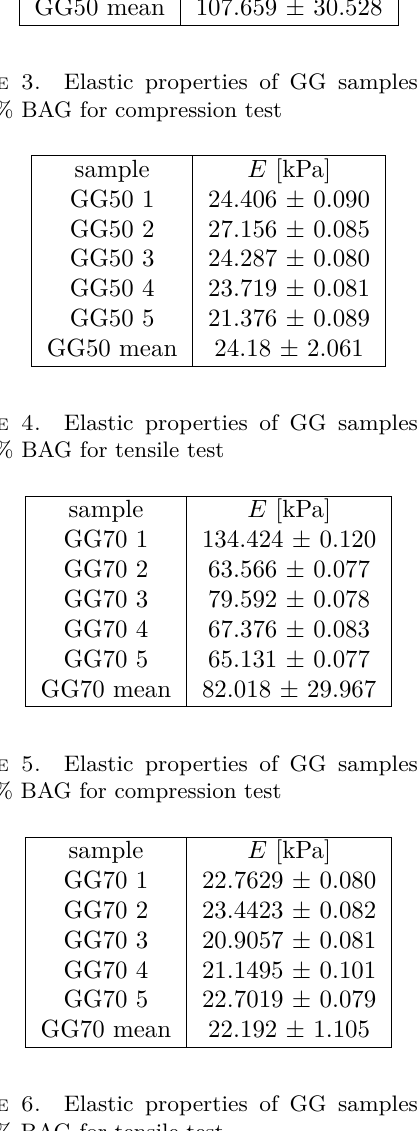
Table 6. Elastic properties of GG samples with 70 wt% BAG for tensile test